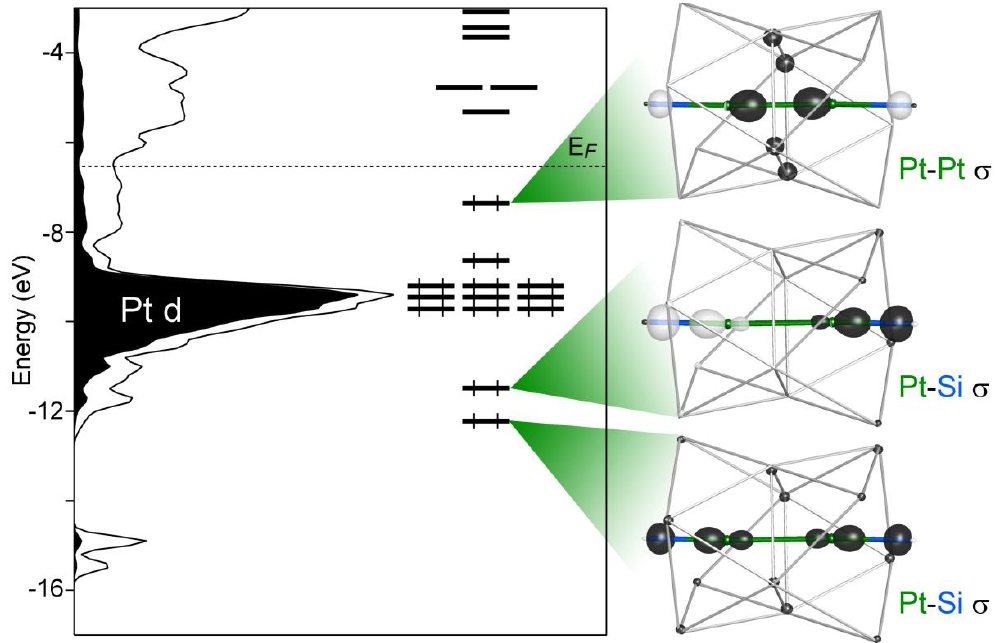
Figure 6. MO diagram for the Pt2 dimer in the context of its coordination environment. Inset: the molecular orbital giving rise to a Ca-supported Pt–Pt